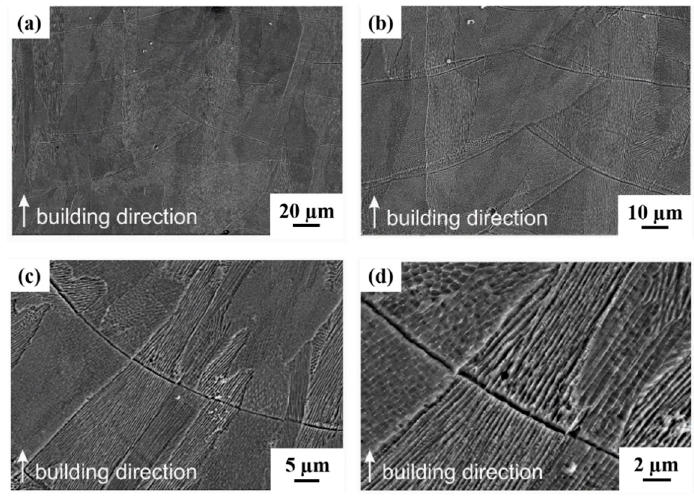
Figure 5. Microstructure of a reference 316L SLM sample at different magnifications.